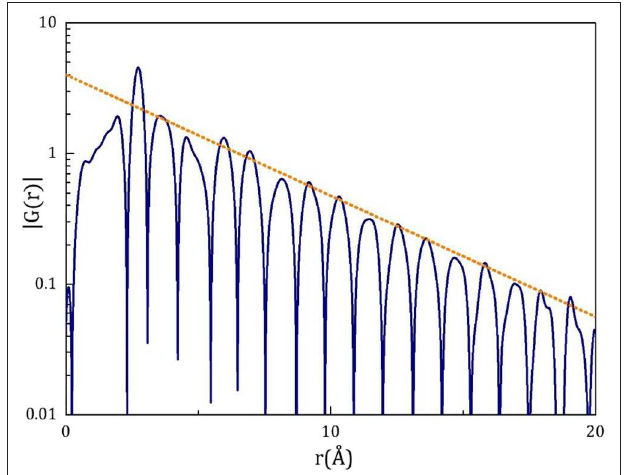
FIGURE 3 | Exponential decay of Pd 42.5 Ni 7.5 Cu 30 P 20 liquid at 600K ( T g